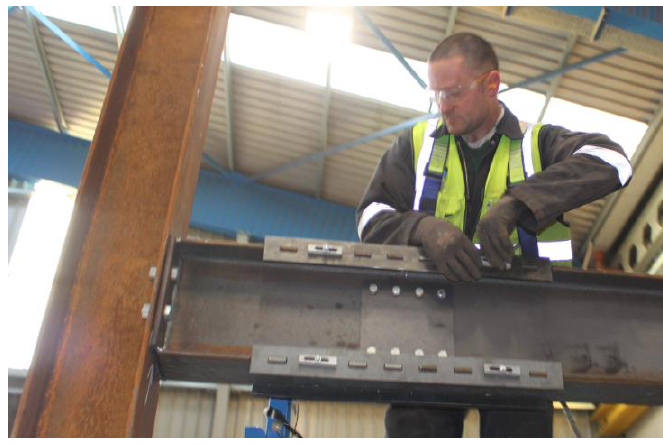
Figure 22. Side plate installation to the stub beam with deviation.